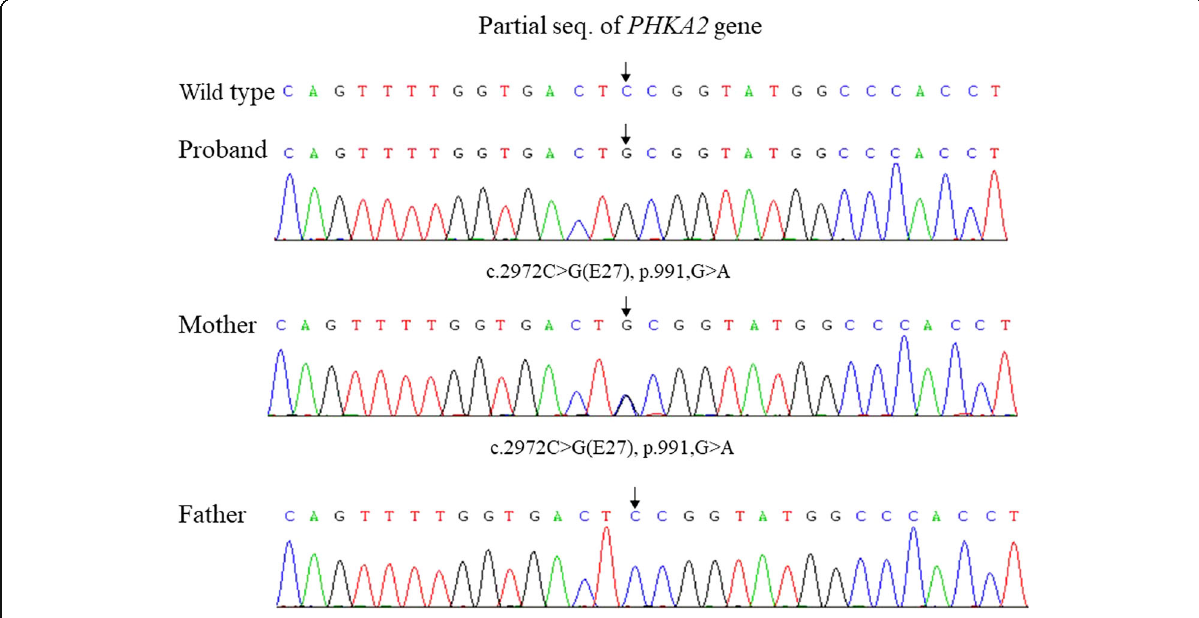
Fig. 2 Results of genetic testing. A heterozygous mutation (p.G991A) at codon 991 of the PHKA2 gene was revealed in the proband and his mother. No mutation was found in the proband ’ s